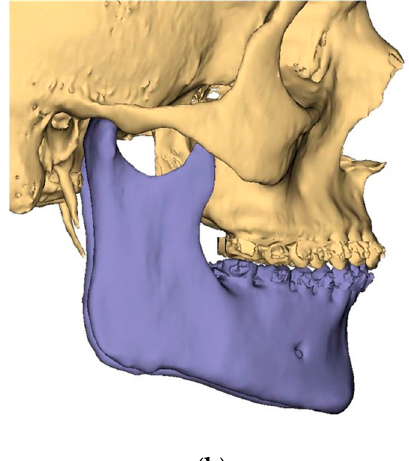
Figure 9. Surgical Plan: Mandible Movement Overview: ( a ) Right side view; ( b ) Left side view.